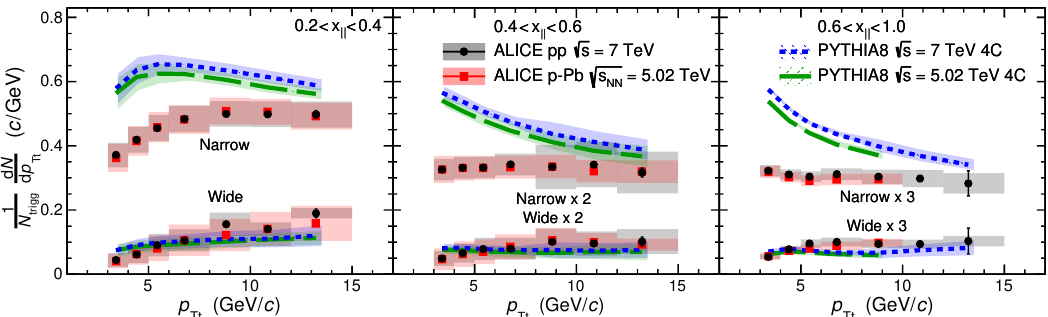
p s = 7 TeV p s NN = 5 : 02 TeV (square symbols) are compared p p s = 7 TeV (short dashed line) and at s = 5 : 02 TeV (long bins with 0 : 2 < x < 0 : 4 on the left, k k < 1 : 0 on the right. The statistical errors are represented k